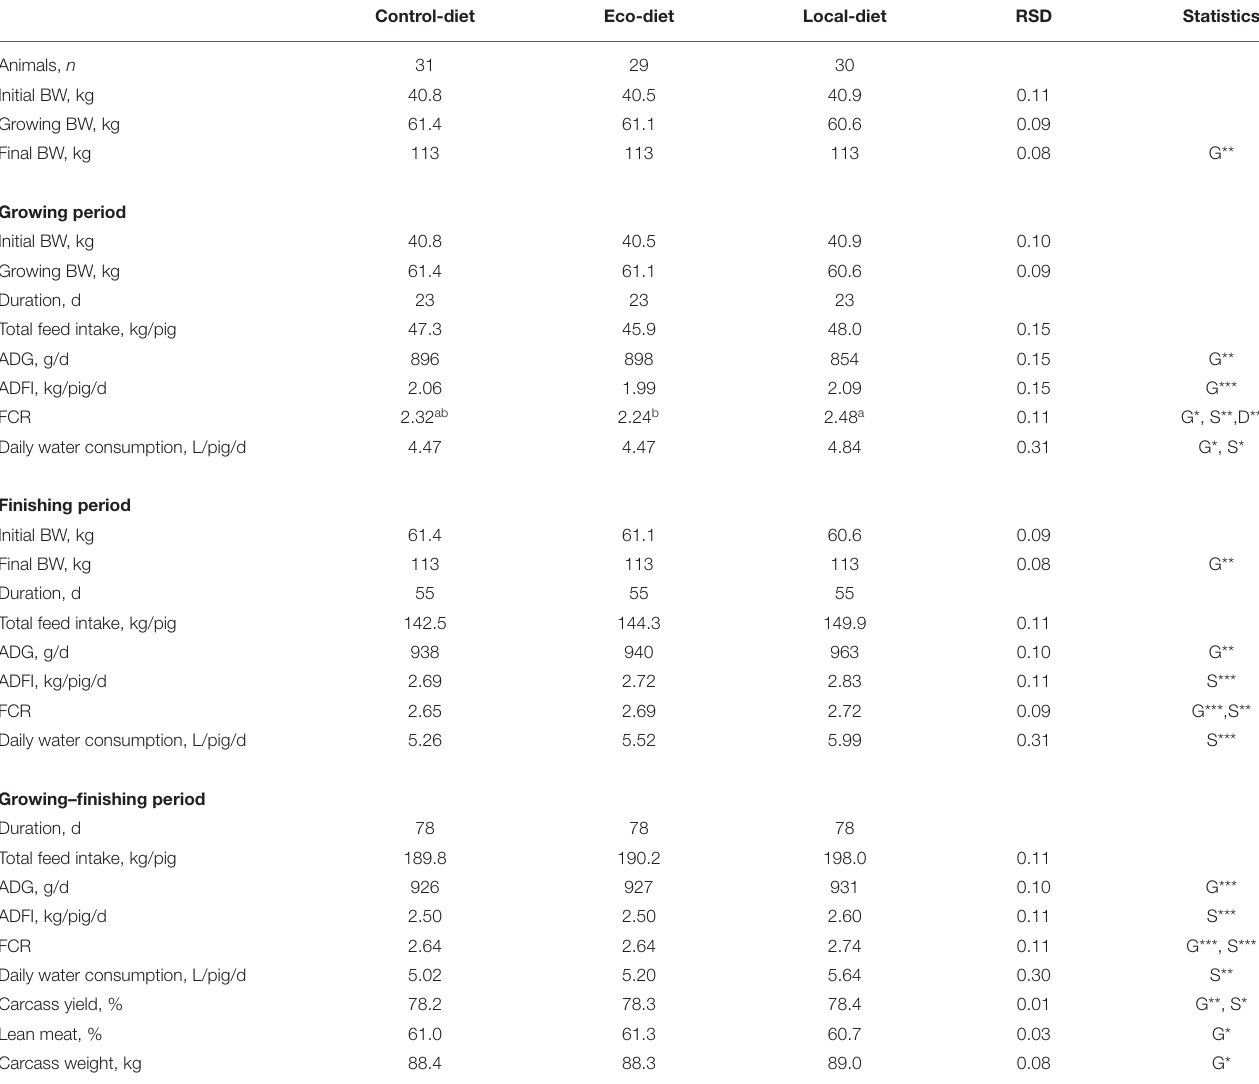
TABLE 3 | Effect of diets on the growth performance of